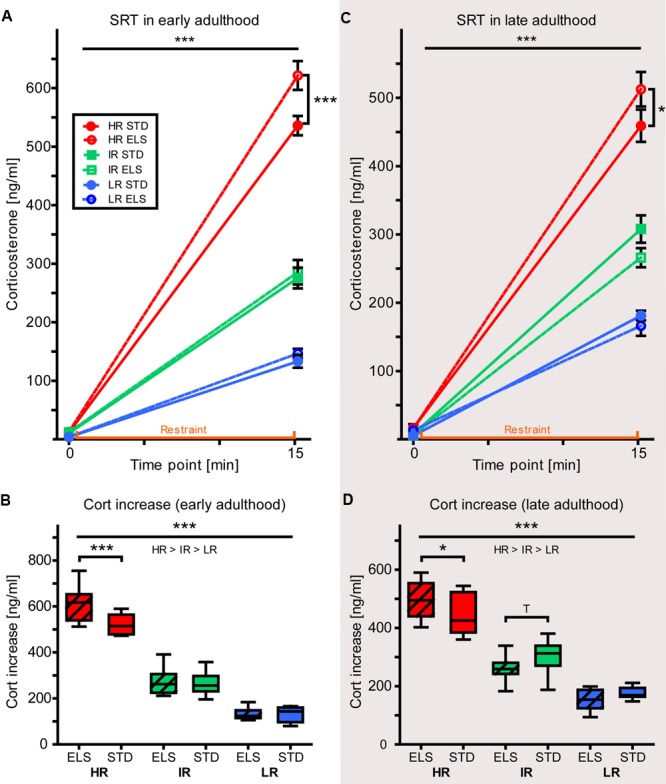
Stress reactivity. Corticosterone concentrations measured in the plasma of HR, IR, and LR mice, raised in ELS or STD housing conditions, collected during the SRT was analyzed using repeated-measured and univariate ANOVA, N = 8–10 per group. Data is presented as line plots showing means and SEM (error bars) and as boxplots showing the median (horizontal line in the box), 25–75% (boxes) and 10–90% (whiskers). (A) In early adulthood, there was a significant effect of time point (initial vs. response) on the plasma corticosterone concentration (within-subjects effect: F1,54 = 1459.996, p < 0.001). The initial corticosterone concentration showed a main effect of line (F2,54 = 6.253, p = 0.004, post hoc tests: HR vs. IR: p = 1.0, HR vs. LR: p = 0.007, IR vs. LR: p = 0.015), but no effect of condition (F1,54 = 0.148, p = 0.702). The response levels of corticosterone showed a main effect of mouse line (F2,54 = 214.164, p < 0.001, post hoc tests: all p < 0.001), as well as a main effect of condition (F1,54 = 5.675, p = 0.021), and an interaction of line and condition (F2,54 = 4.232, p = 0.020, post hoc tests, ELS vs. STD: HR: p < 0.001, IR: p = 0.742, LR: p = 0.857). (B) The increase in plasma corticosterone levels in response to 15-min restraint showed a main effect of line (F2,54 = 223.319, p < 0.001, post hoc tests: all p < 0.001), a main effect of condition (F1,54 = 6.022, p = 0.017), as well as an interaction of line and condition (F2,54 = 6.243, p = 0.016, post hoc tests ELS vs. STD: HR: p < 0.001, IR: p = 0.776, LR: p = 0.949). (C) In late adulthood, there was a significant effect of time point (initial vs. response) on the plasma corticosterone concentration (within-subjects effect: F1,53 = 1957.027, p < 0.001). The initial corticosterone concentration showed a trend for a main effect of mouse line (F2,53 = 3.023, p = 0.057, post hoc tests: HR vs. IR: p = 0.063, HR vs. LR: p = 0.278, IR vs. LR: p = 1.0), but no effect of condition (F1,53 = 0.381, p = 0.540). The response levels of corticosterone showed a main effect of mouse line (F2,54 = 140.272, p < 0.001, post hoc tests: all p < 0.001), and interaction of line and condition (F2,53 = 3.468, p = 0.038, post hoc tests, ELS vs. STD: HR: p = 0.048, IR: p = 0.118, LR: p = 0.580). (D) The increase in plasma corticosterone levels in response to 15-min restraint showed a main effect of line (F2,53 = 166189, p < 0.001, post hoc tests: all p < 0.001), and an interaction of line and condition (F2,53 = 4.544, p = 0.015, post hoc tests, ELS vs. STD: HR: p = 0.026, IR: p = 0.0.092, LR: p = 0.344). ∗∗∗p ≤ 0.001, ∗∗p ≤ 0.01, ∗p ≤ 0.05, Tp ≤ 0.1. Main effects of line are represented above a horizontal line above the graphs. The respective post hoc test statistics are indicated underneath the line with: </>, p ≤ 0.05; ≤/≥, p ≤ 0.1; ≈, p > 0.1. Post hoc statistics for main effects of condition and the interaction are presented above or next to the appropriate boxes.